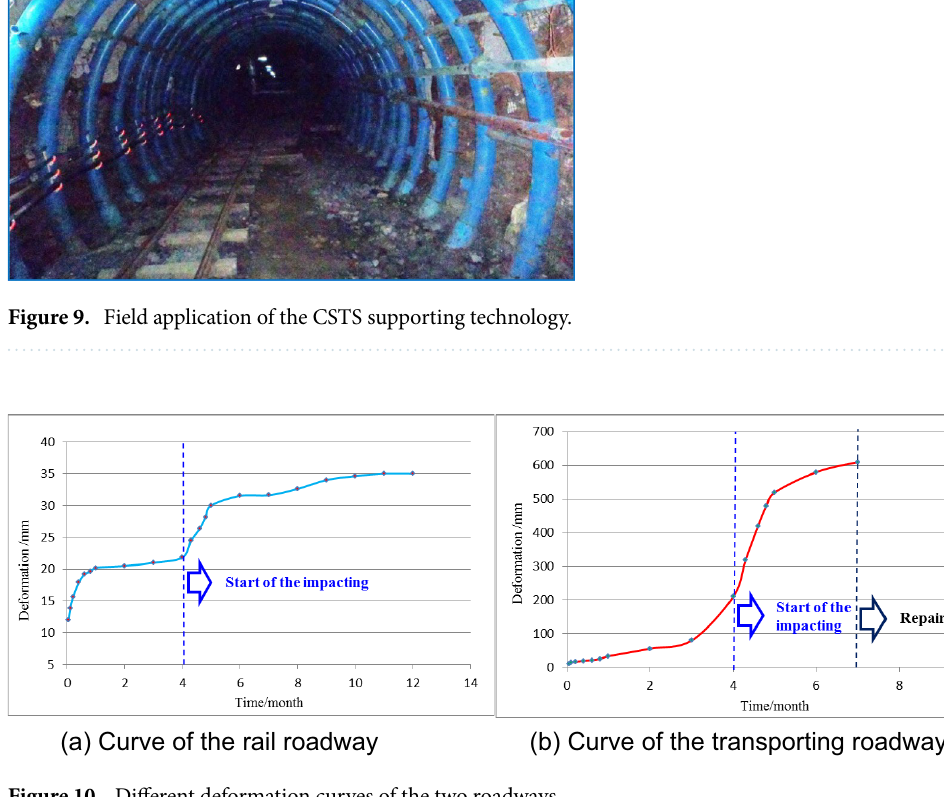
Figure 10. Different deformation curves of the two